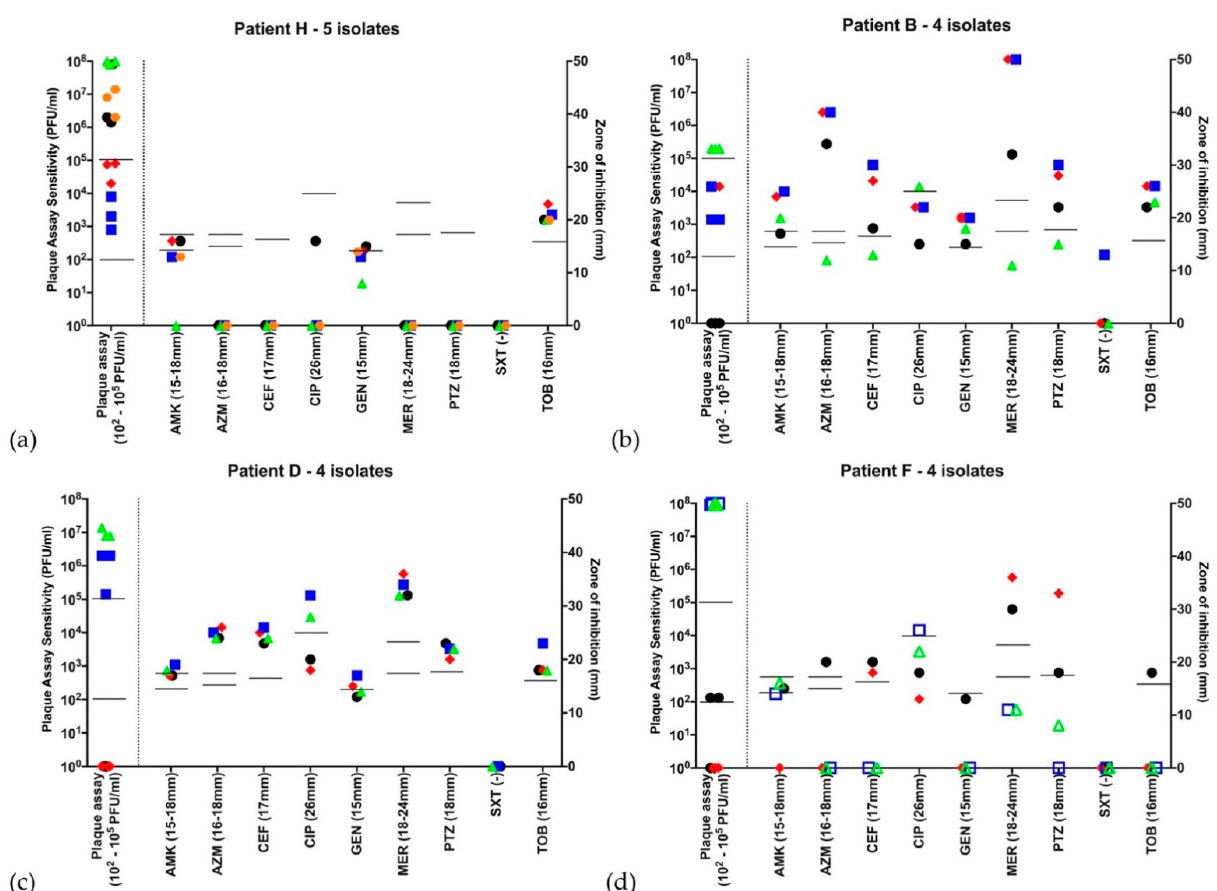
Figure 1. Example antibiograms and bacteriophage sensitivity profiles for 4 different patients chosen to illustrate variability in results. Isolates are graphically represented by different symbols chronologically throughout the year. The first isolate is represented by , with subsequent isolates , , , , if there were 5 isolates through the course of 2016. Open symbols represent different strains, identified by VNTR analysis. Abbreviations: AMK: amikacin; AZM: aztre- onam; CEF: ceftazidime; CIP: ciprofloxacin; GEN: gentamicin; MER: meropenem; PTZ: piperacillin-tazobactam; SXT: co- trimoxazole (no EUCAST breakpoint); TOB: tobramycin. Disc diffusion assay for antibiotic sensitivity testing was per- formed once at each time point and EUCAST sensitivity cutoffs are indicated by the bars. Biological triplicates of phage